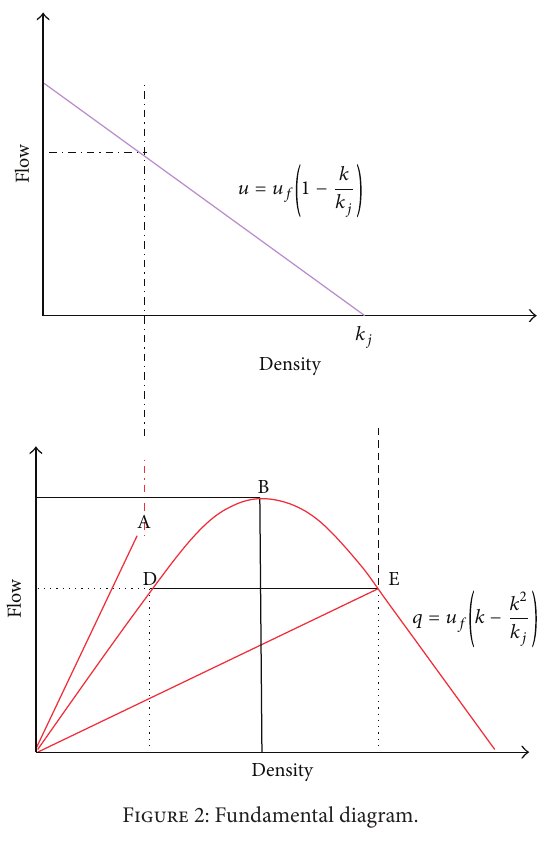
Figure 2: Fundamental diagram.